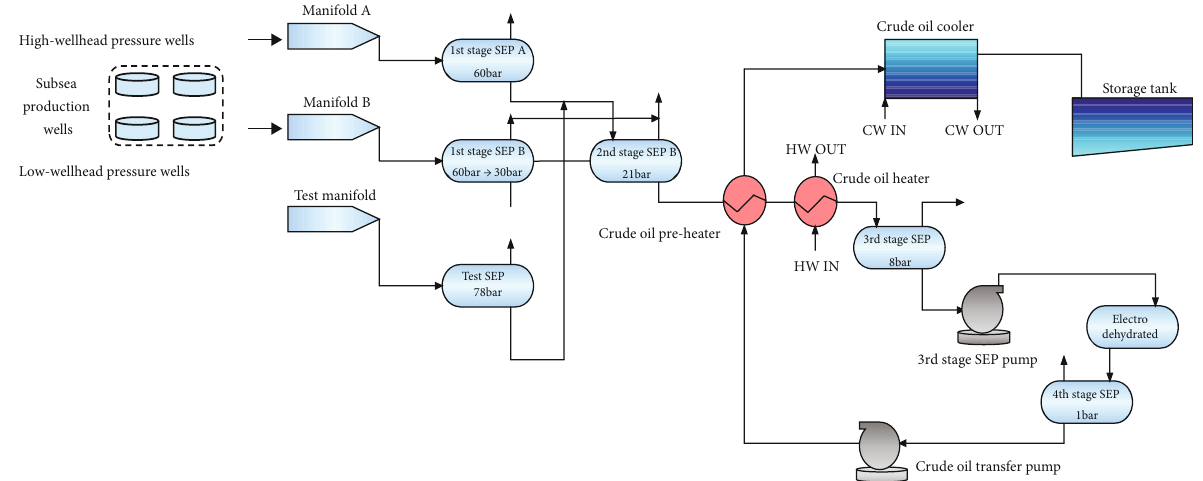
Figure 9: The transformation of fi rst-stage separators in Akpo oil fi